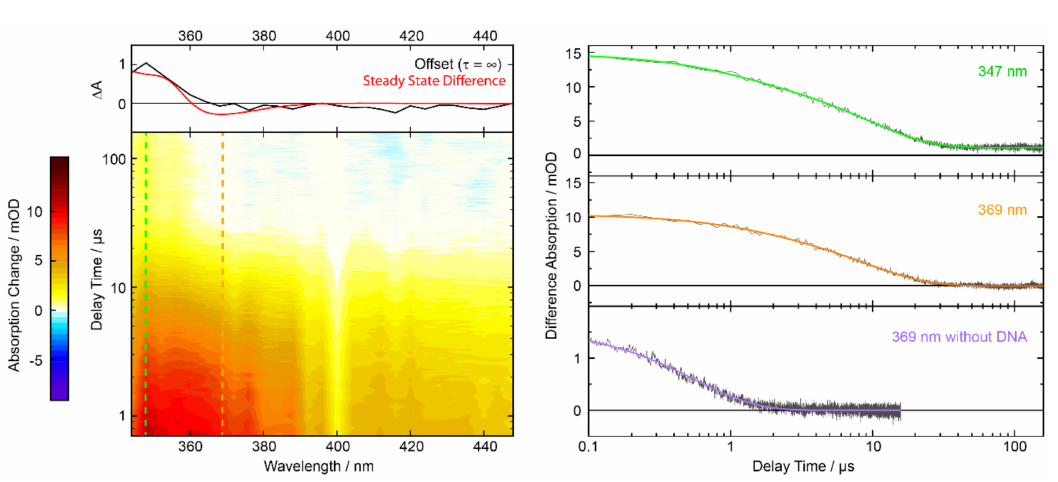
Figure 5. Nanosecond transient absorption of 8-MOP (0.3 mM) with AT-DNA (3 mM) in aerated bu ff er solution after excitation at 355 nm. Left: The transient absorption in the contour plot is color-coded. The dashed lines mark the respective time trace shown on the right. On top is the o ff set spectrum in comparison with the steady-state signature (red, scaled to match the o ff set spectrum) after irradiation at 390 nm. Right: Time traces at 347 and 369 nm. The third time trace shows 8-MOP (0.2 mM) without DNA in water. The colored lines show bi-exponential (green and orange) or single exponential (violet) fits of the data.